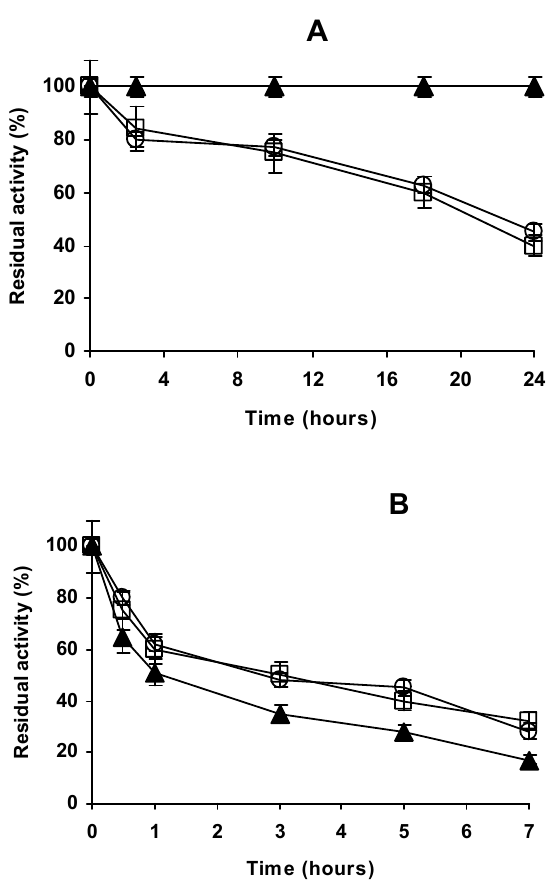
Figure 4. Preparation and inactivation of β -gal-MANAE treated with 0.1% glutaraldehyde: ( A ) Activity evolution of β -gal-MANAE immobilized at pH 5 and treated with 0.1% glutaraldehyde at pH 7 and 25 ◦ C using a support having 40 µ mol MANAE groups/g of support. Other specifications are described in methods. ( B ) Inactivation of different β -gal-MANAE preparations at pH 5 and 55 ◦ C. Circles: β -gal-MANAE treated with glutaraldehyde in the presence of 100 mM glucose. All experiments were performed in triplicate and the values are given as mean value ± the experimental error. Squares: β -gal-MANAE treated with glutaraldehyde in the absence of glucose. Triangles: β -gal-MANAE no treated with glutaraldehyde.